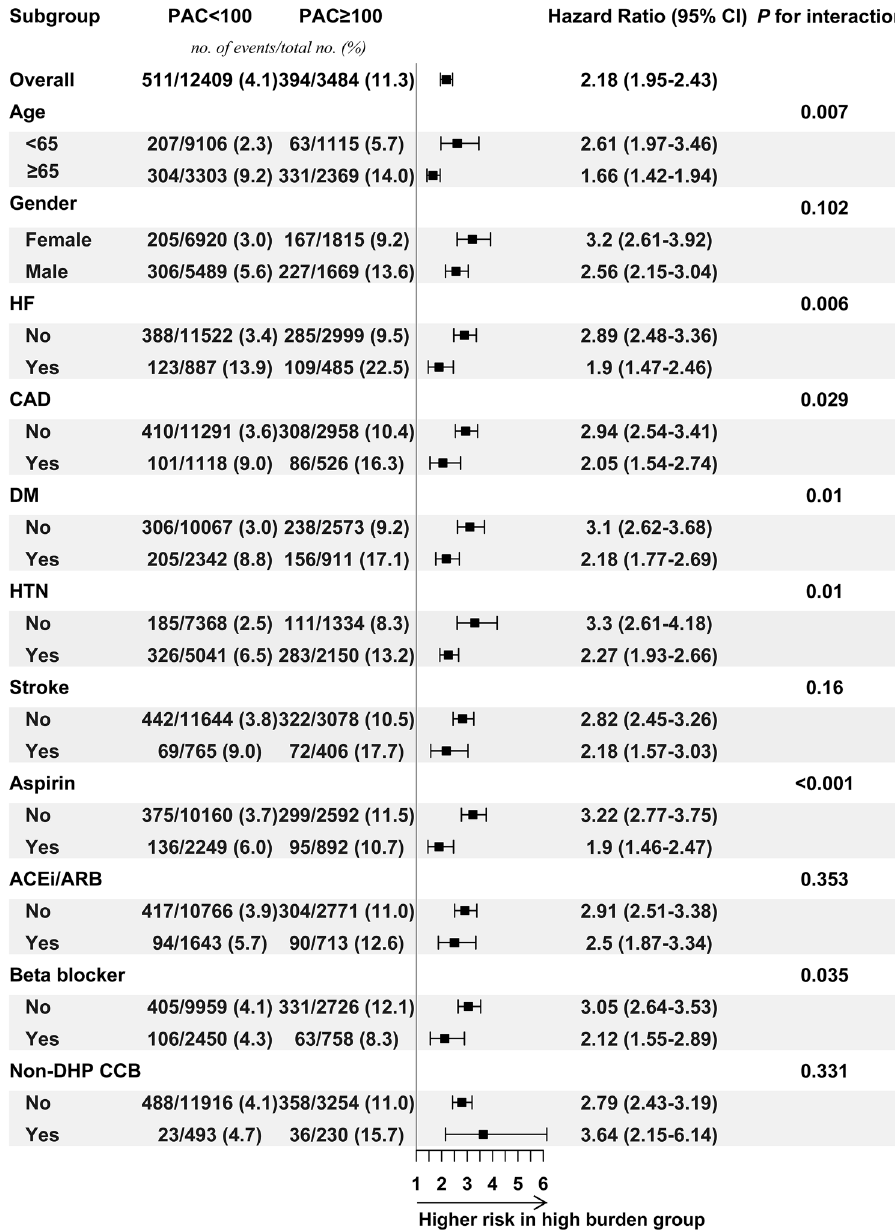
Figure 3. Subgroup analysis. Patients were divided into two groups based on a PAC cut-off value of 100. High- burden group had greater risk of all-cause mortality than low-burden group, and this finding was consistent across all pre-specified groups. Abbreviation: ACEi/ARB, angiotensin-converting enzyme inhibitor/angiotensin receptor blocker; CAD, coronary artery disease; CI, confidence interval; DM, diabetes mellitus; HF, heart failure; Non-DHP CCB, non-dihydropyridine calcium channel blocker; PAC, premature atrial